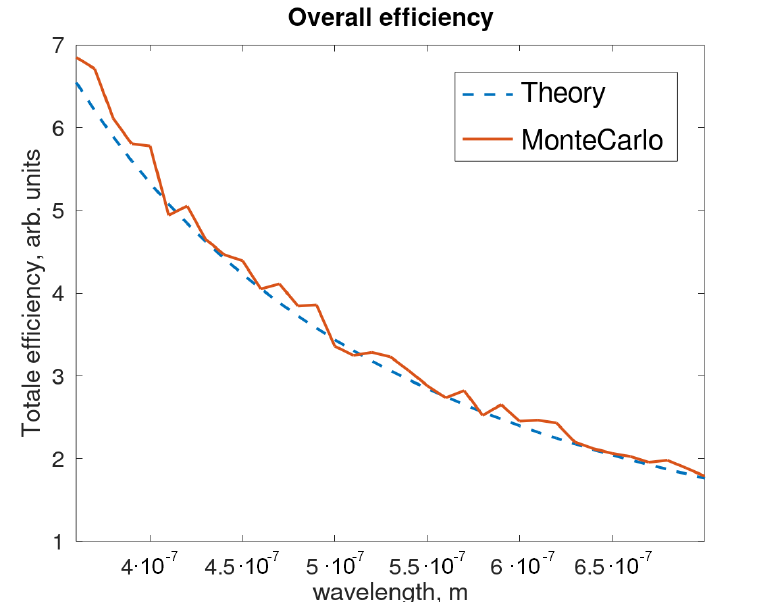
Figure 10. Simulation of total efficiency which could be obtained with a Kerr shutter characterized by the parameters reported in Table